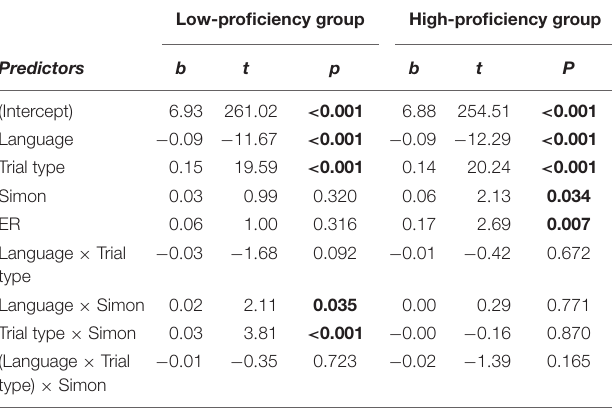
TABLE 4 | Estimated coefficients (logRT) from the mixed-effects models for examining the switching cost, respectively, in low-and high-proficiency